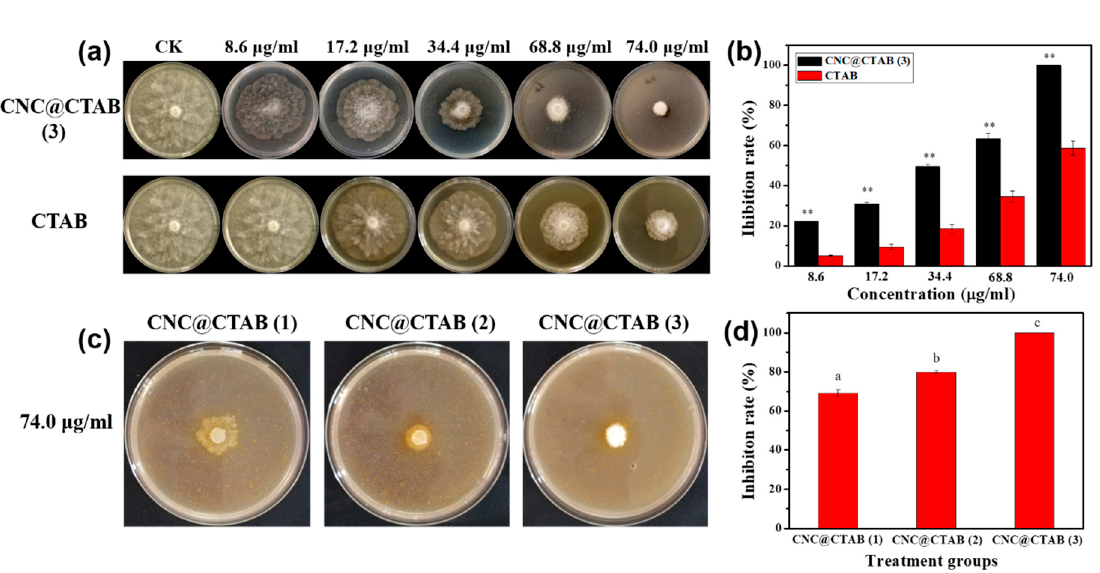
Figure 2. Comparison of the anti-oomycete activity of the CNC@CTAB and CTAB against Phytophthora capsici ( a ). The inhibition rate statistics of the CTAB and CNC@CTAB against Phytophthora capsici ( b ). Comparison of the anti-oomycete activity of the CNC@CTAB with different